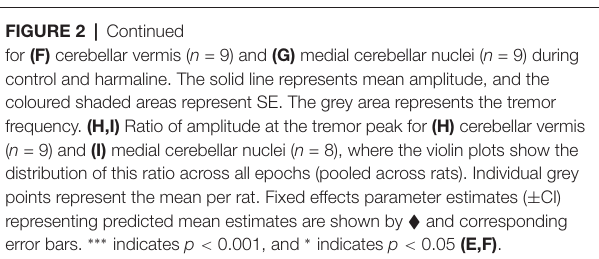
greater than two standard deviations of the group mean.